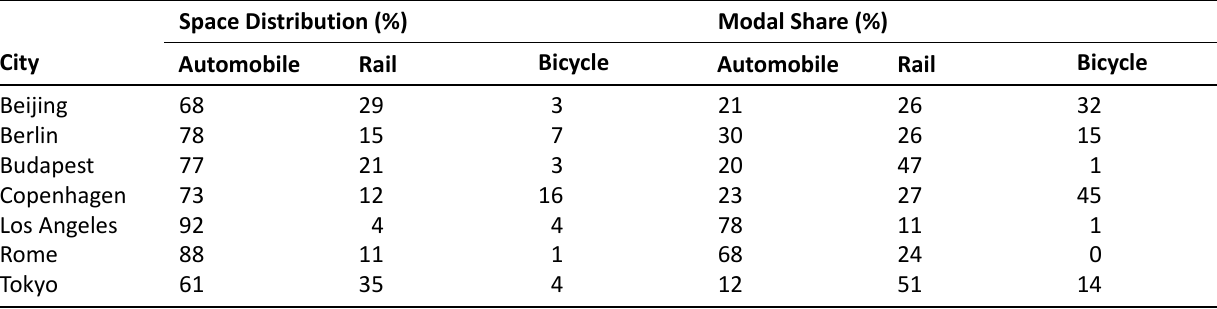
Table 1. Mobility space distribution versus modal share in seven selected cities. Modal shares do not sum up to 100 because of walking which accounts for the remainder. Some space distribution rows do not sum up to 100 due to rounding. Space Distribution (%) Modal Share (%)